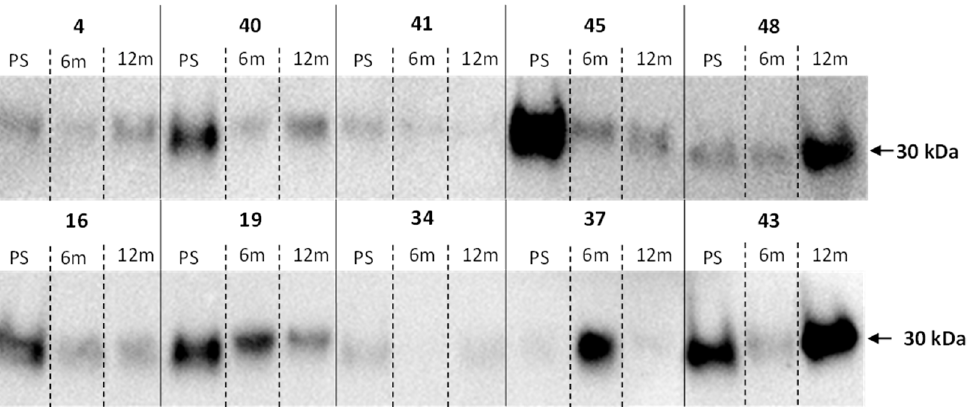
Figure 1. Western blotting of a bariatric patient’s saliva for adiponectin. The numbers correlate with the patient, PS is the pre-Roux-en-Y gastric bypass surgery sample, 6 m is the 6-month follow-up sample, and 12 m is the 12-month follow-up sample.